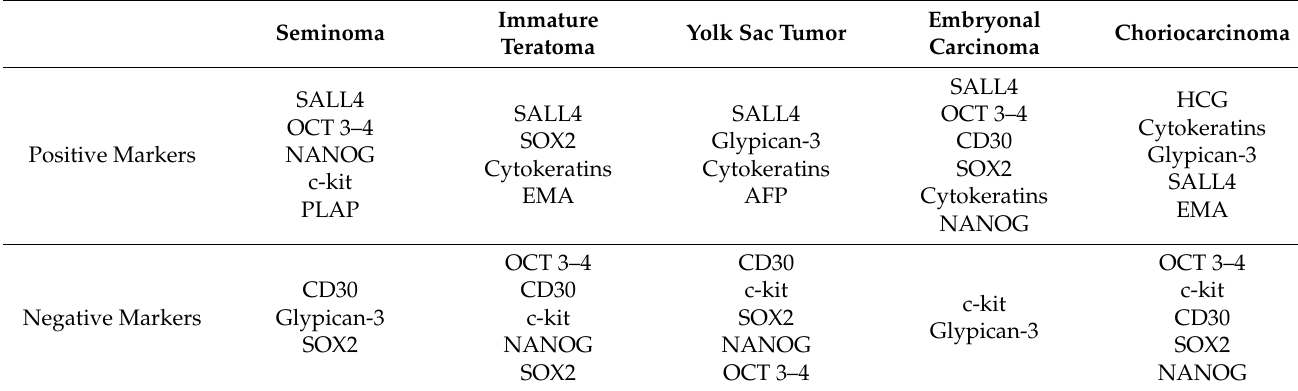
Table 2. Immunohistochemistry in germ cell